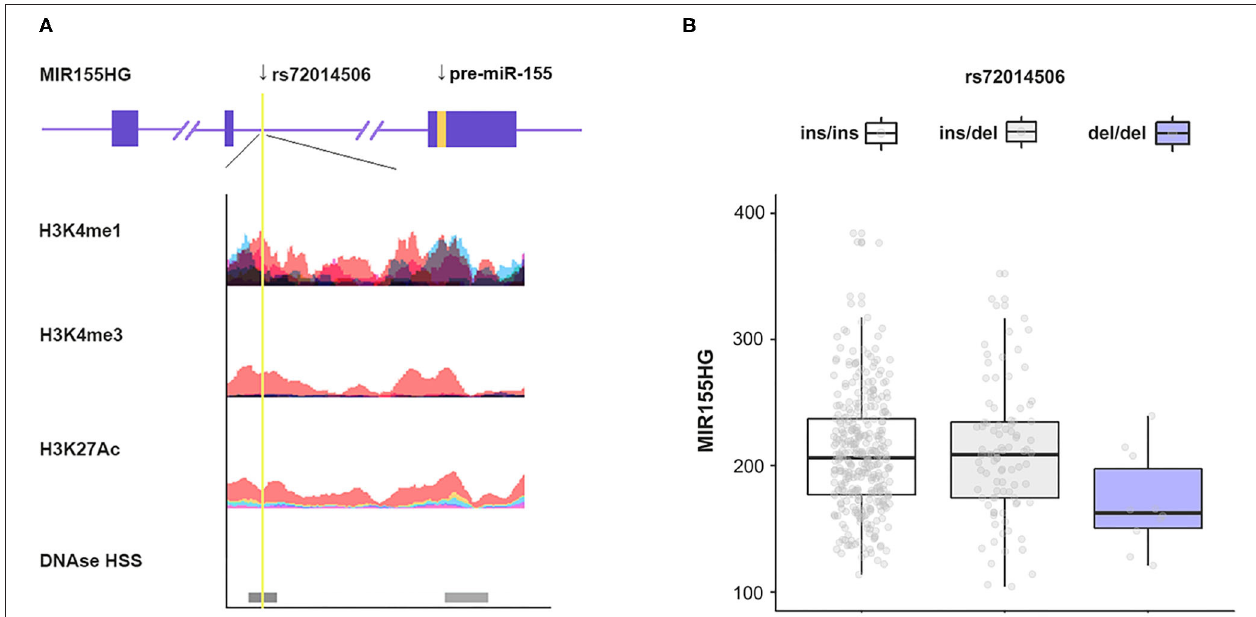
FIGURE 1 | Screening of polymorphism. (A) Annotation of regions containing rs72014506 using the ENCODE database. The yellow line indicates the location of rs72014506. Colored histograms denote histone modification markers (H3K4me1, H3K4me3, and H3K27ac) in seven human cell types (GM12878, H1-hESC, HSMM, HUVEC, K562, NHEK, and NHLF). The darkness of DNase I hypersensitive represents the maximum signal strength observed in 95 cell lines. (B) MIR155HG mRNA expression levels as a function of genotype of rs72014506 determined by eQTLs analysis ( P <